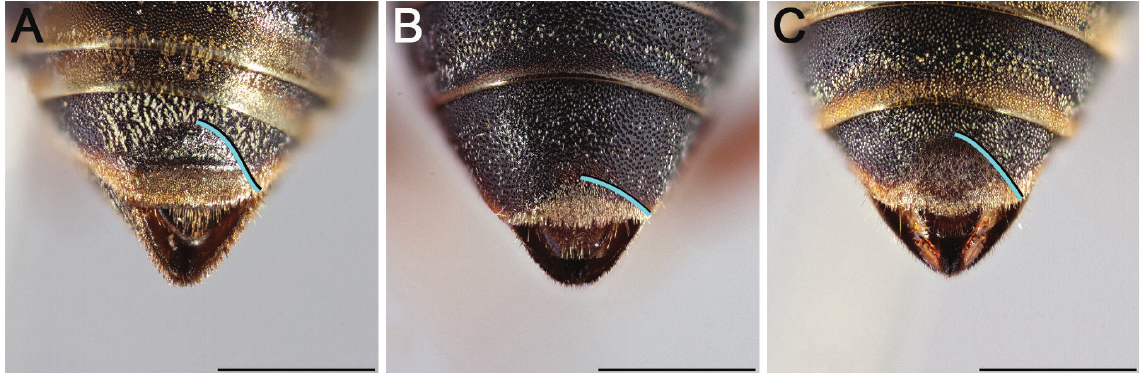
Fig. 12. Pseudopygidial area of female, dorsal view. A . E. fumipennis Say, 1837, which consists of a basal impressed triangular or semicircular portion covered in silvery short, appressed setae differentiated from a transverse band of coppery short, appressed setae along the posterior-facing apical margin of T5. B . E. bifasciatus Cresson, 1864, which is more than twice as wide as long. C . E. obscuripes Cockerell, 1917 stat. nov., which is not more than twice as wide as long. The pseudopygidial area is the apical portion of T5 that changes slope from the rest of the tergum and is covered in short, coppery or silvery hairs uniform in length (posteromesad the light blue lines). Scale bars = 1